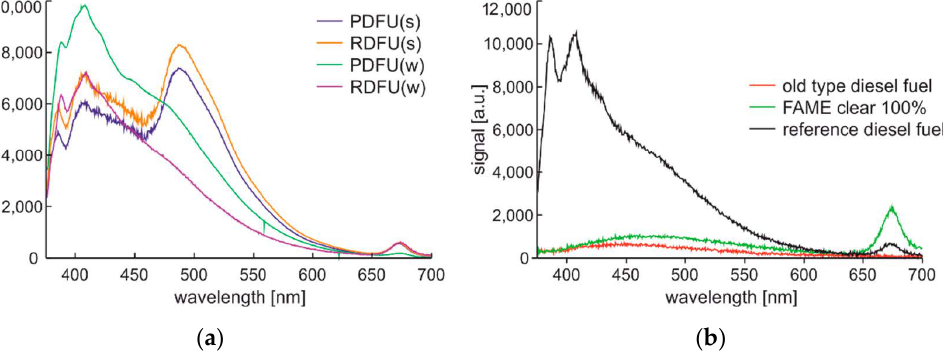
Figure 9. Complete spectra data of fuels examined at 0.5 min after UV source activation: ( a ) Premium diesel fuel and regular diesel fuel of winter and summer types; ( b ) old-type diesel fuel, 100% of FAME clear component, and reference diesel fuel obtained directly from a refinery. On the left side of Figure 9, the shape of the fluorescence signal is similar for the cluster of winter and summer fuel types but not the same. In both cases, the signal is lower